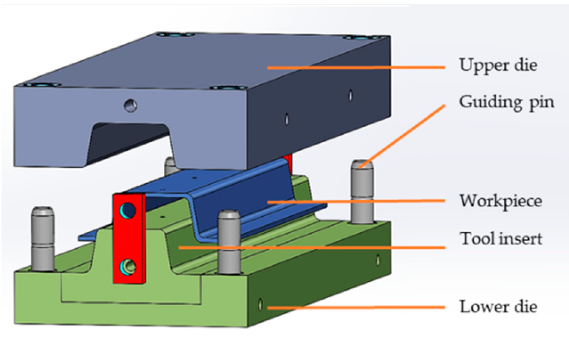
Figure 3. Schematic set-up of the forming process.